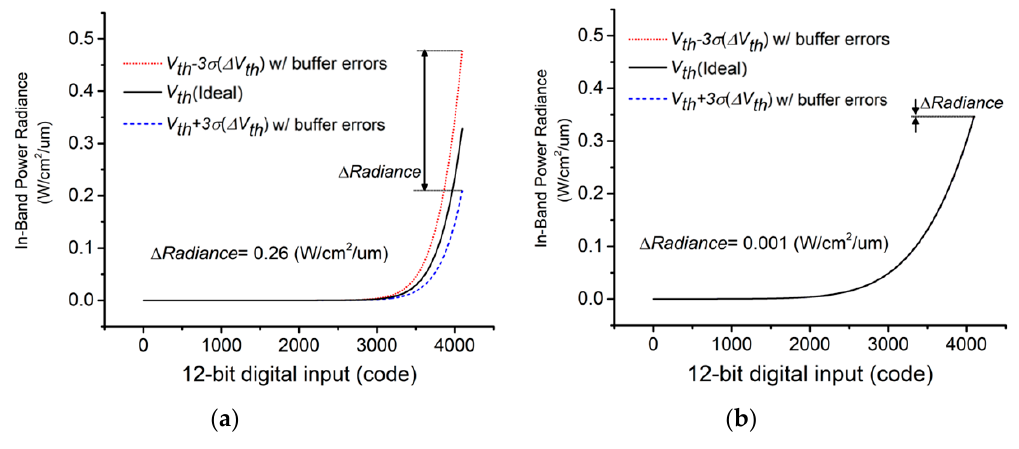
Figure 9. Radiance analysis of IR emitter: ( a ) conventional RIIC; ( b ) proposed RIIC.